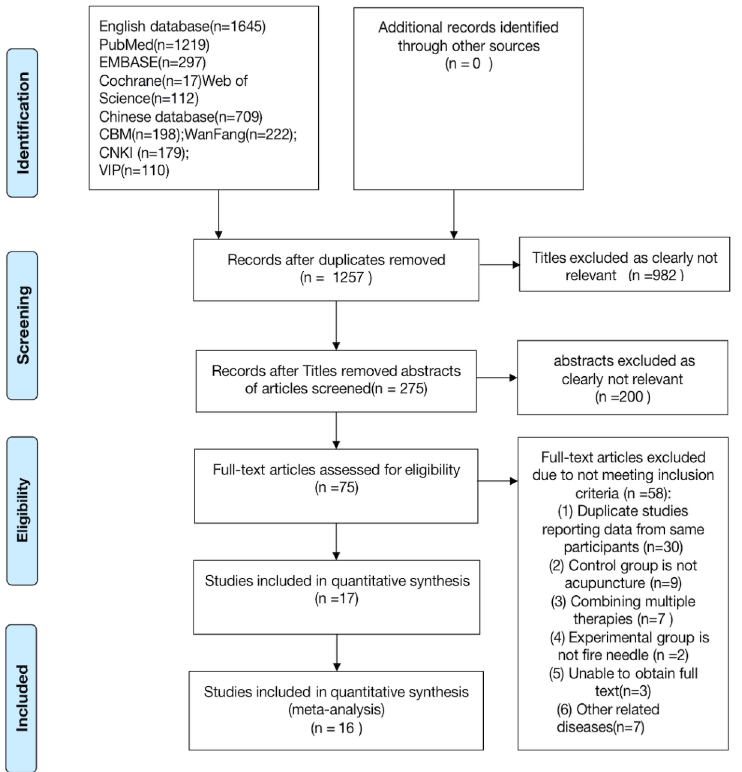
Fig 1. Modified PRISMA flow diagram of included/excluded